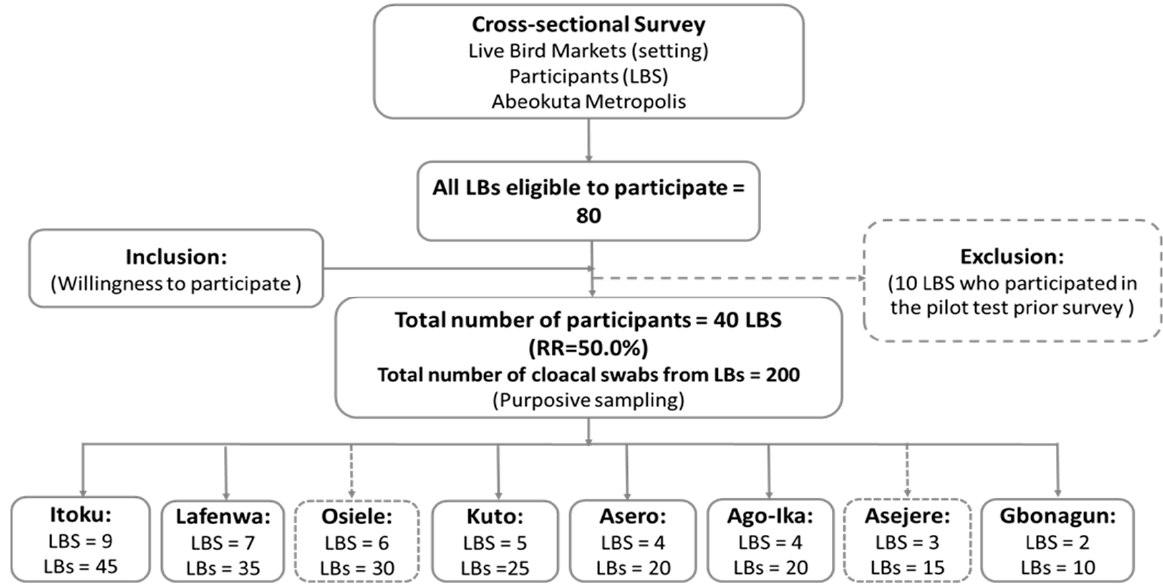
Figure 1. Summary study flowchart indicating the outcome of respondents’ recruitment process and sample collection.